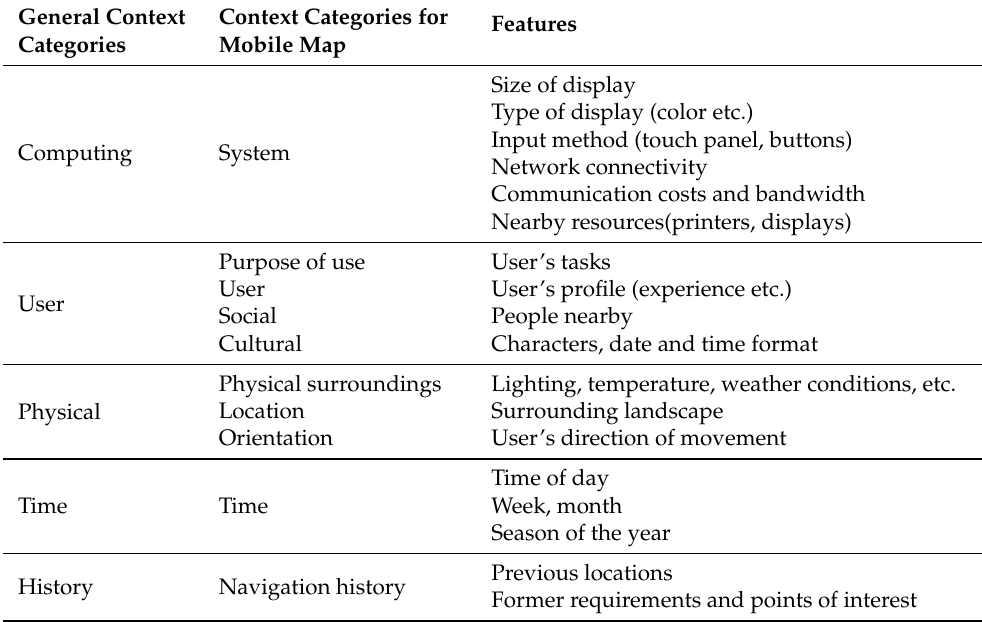
Table 1. Categorization of contexts and their characteristics for mobile cartographic services (ex- tracted from